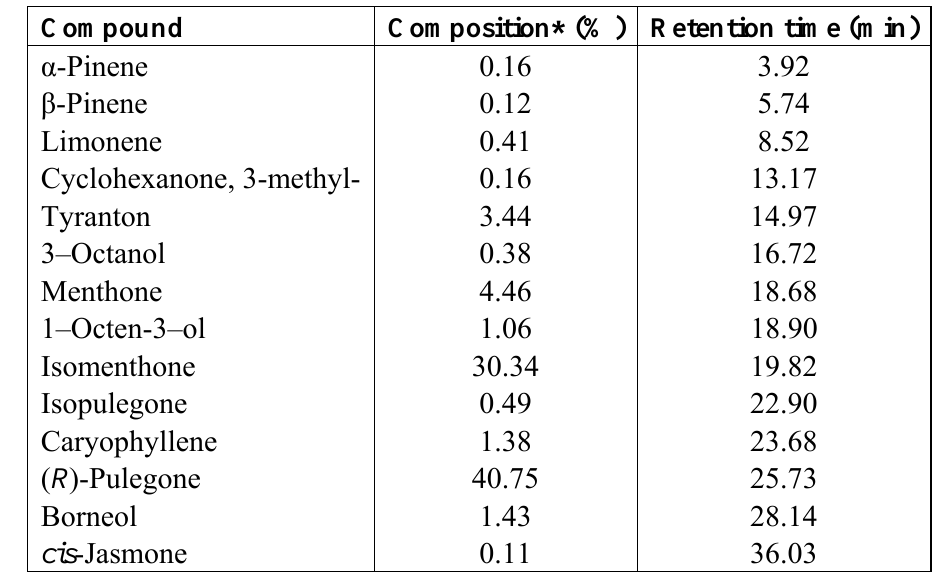
Table 1. Composition of the essential oil isolated from H. marifolia